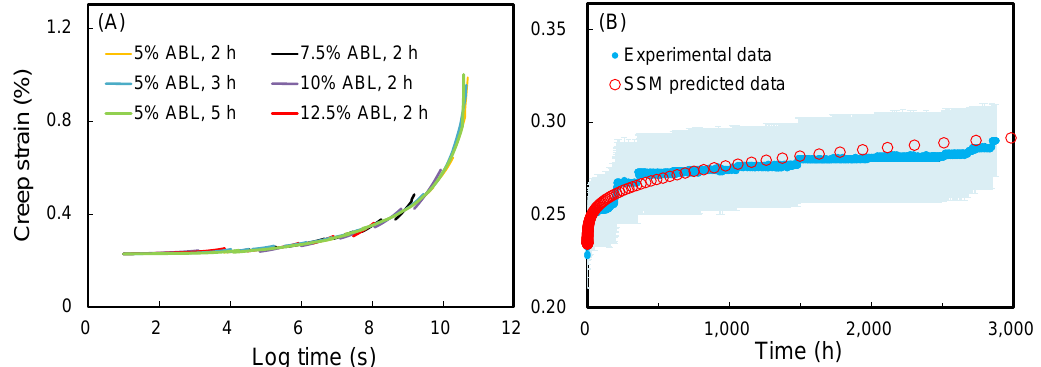
Figure 6. ( A ) Master curves of timber from different SSM testing parameters at a logarithmic time scale. ( B ) SSM-predicted creep curve and experimental creep data of timber at a normal time scale. Experimental creep data are displayed as the mean (blue line) ± SD (light blue ribbon) ( n = 3).